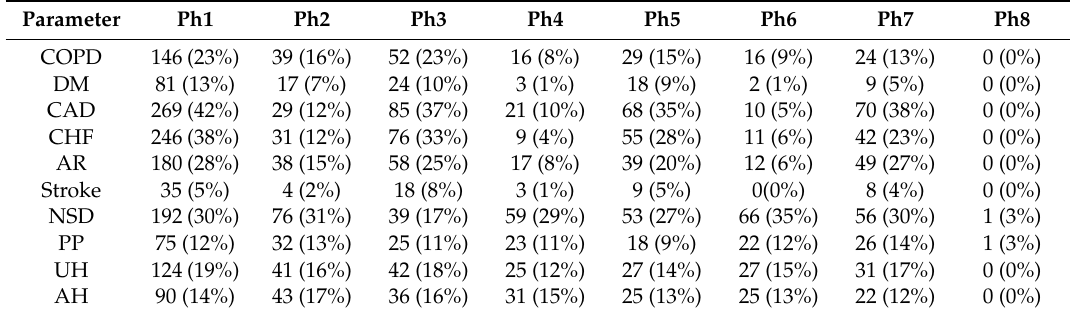
Table 4. Comorbidities prevalence for phenotypes Ph1–Ph8 in the male cohort (with N =